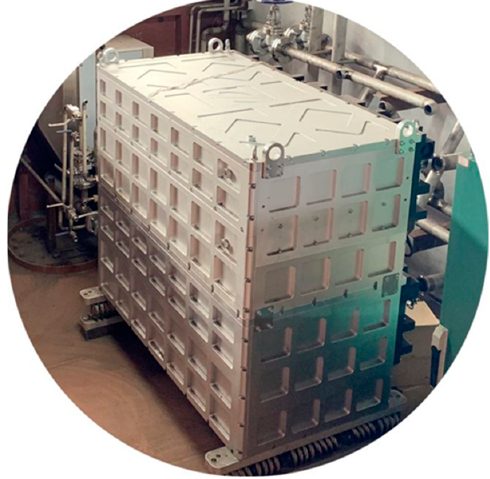
Figure 34. The 70 kW marine PEMFC developed by Wuhan Institute of Marine Electric Propulsion [159].